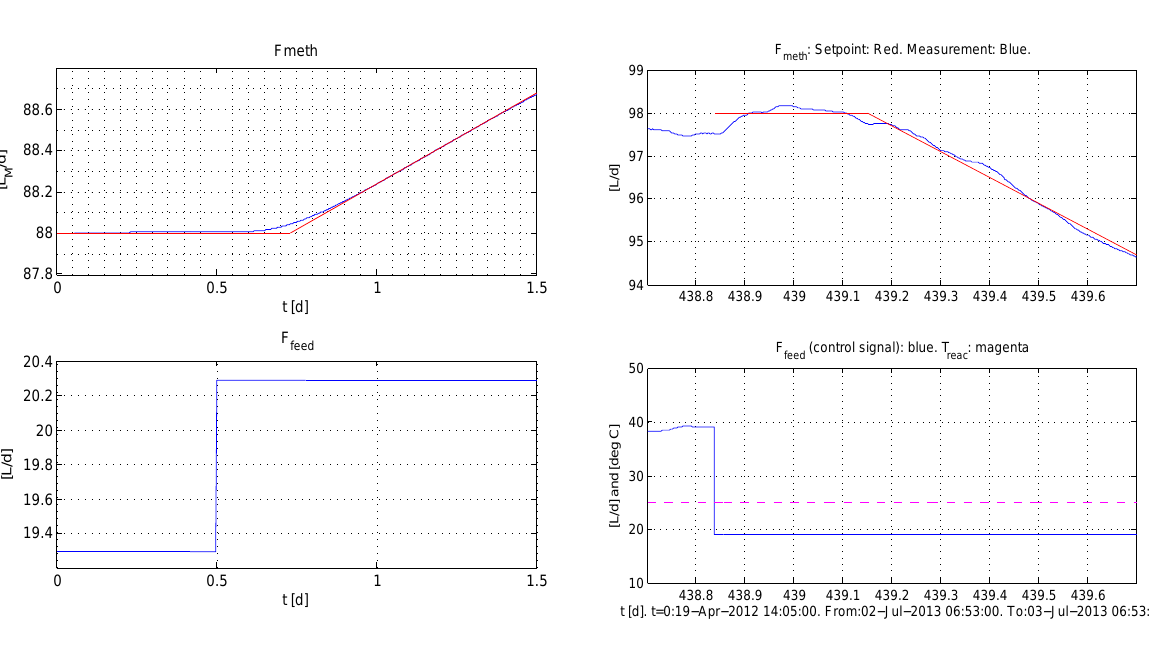
Figure 7: Simulated open-loop step response where Figure 8: Open-loop step response for the real F feed is changed as a step of amplitude 1 L/d.